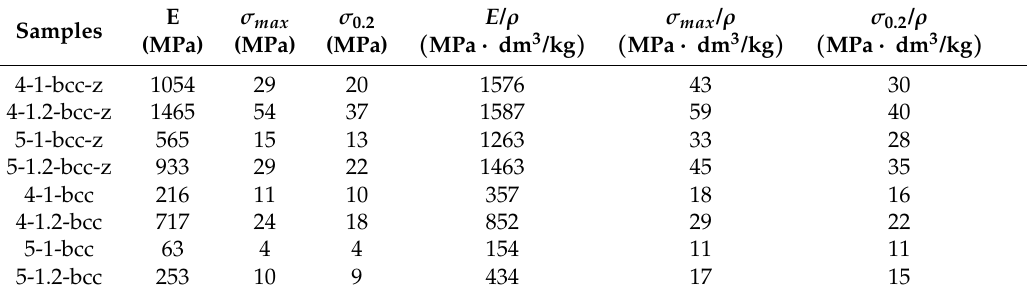
Table 2. Mechanical properties of the specimens